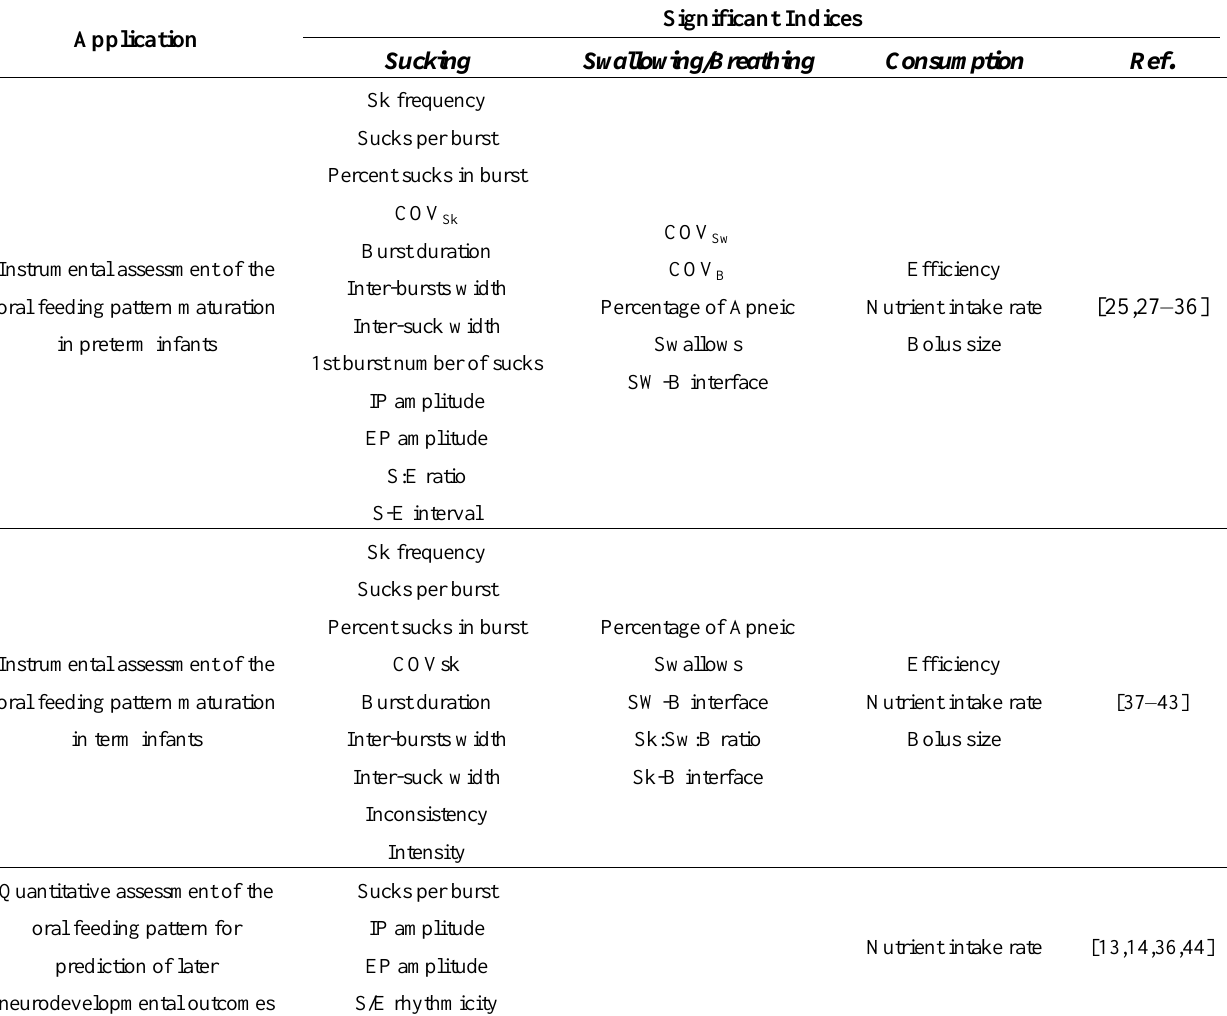
Table 1. Overview of the most significant indices adopted for the instrumental assessment of infants’ NS behavior during bottle